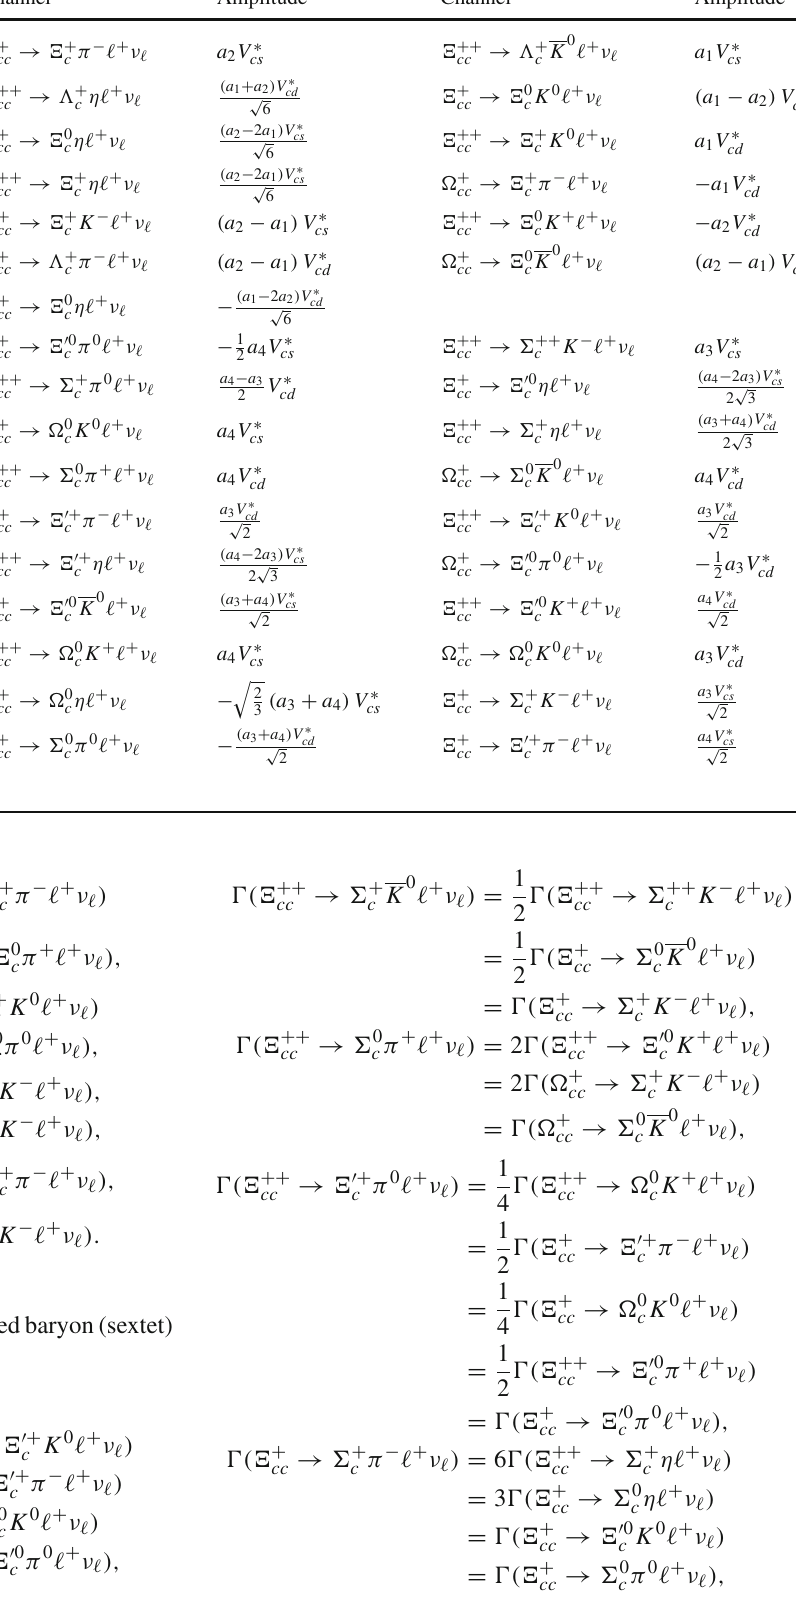
Table 4 Semileptonic (cid:2) cc and (cid:5) cc decays into a singly charmed baryon (anti-triplet or sextet) and a light meson Channel Amplitude Channel Amplitude